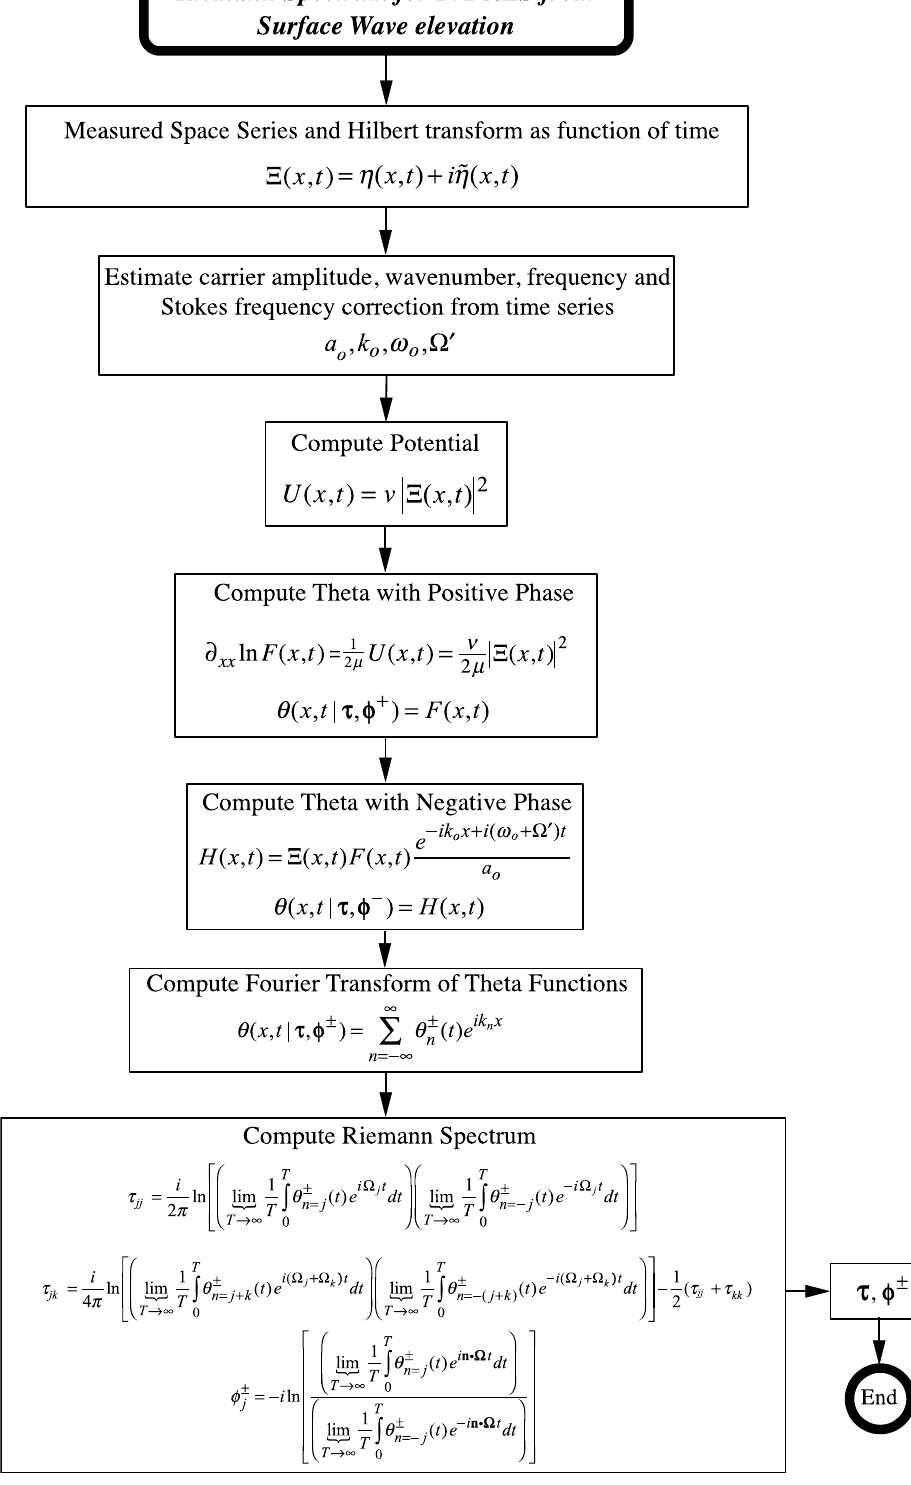
Figure 15. Determine Riemann spectrum from a wave field  ( x , t ) . Notice that in the box Figure 15. Determine Riemann spectrum τ , φ ± from a wave field η ( x , t ) . Notice that in the box labeled labeled “Compute Riemann Spectrum,” the frequencies are the usual ones determined with the “Compute Riemann Spectrum,” the frequencies are the usual ones determined with the modulational   j ( K j ) , which are incommensurable, and therefore require modulational dispersion relation  j dispersion relation Ω j = Ω j ( K j ) , which are incommensurable, and therefore require the usual limits the usual limits over time. over